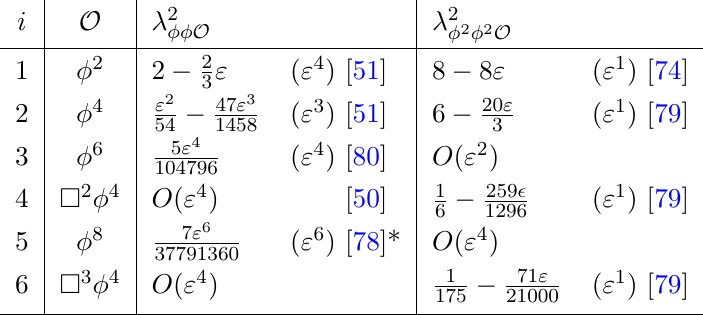
Table 2 . OPE coefficients for Z 2 -even scalars. The value of [78] is a conjecture, see